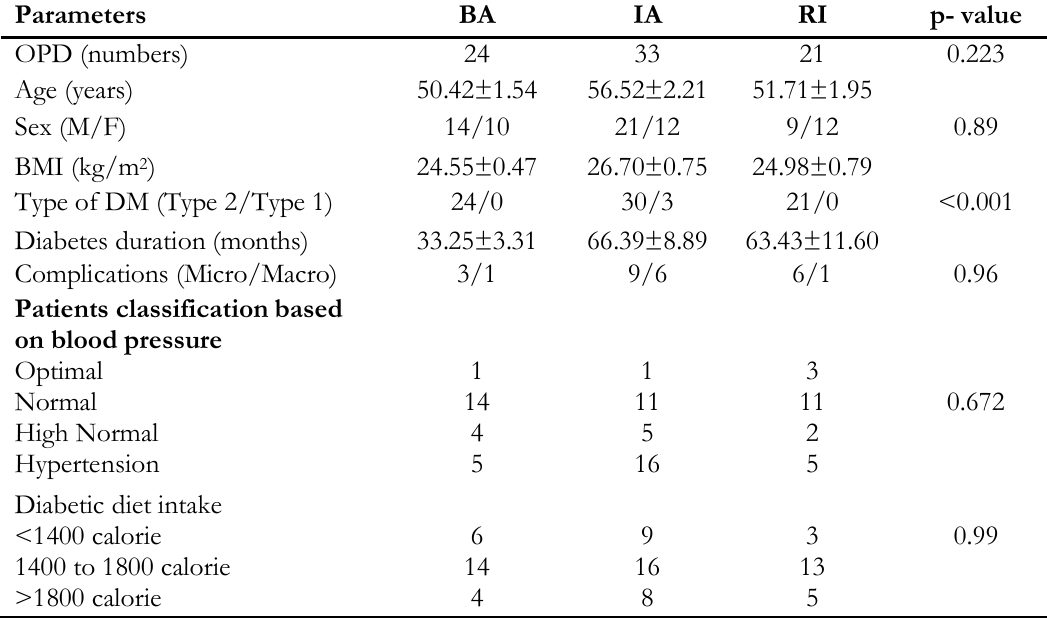
Table I. Base line characteristics of participants